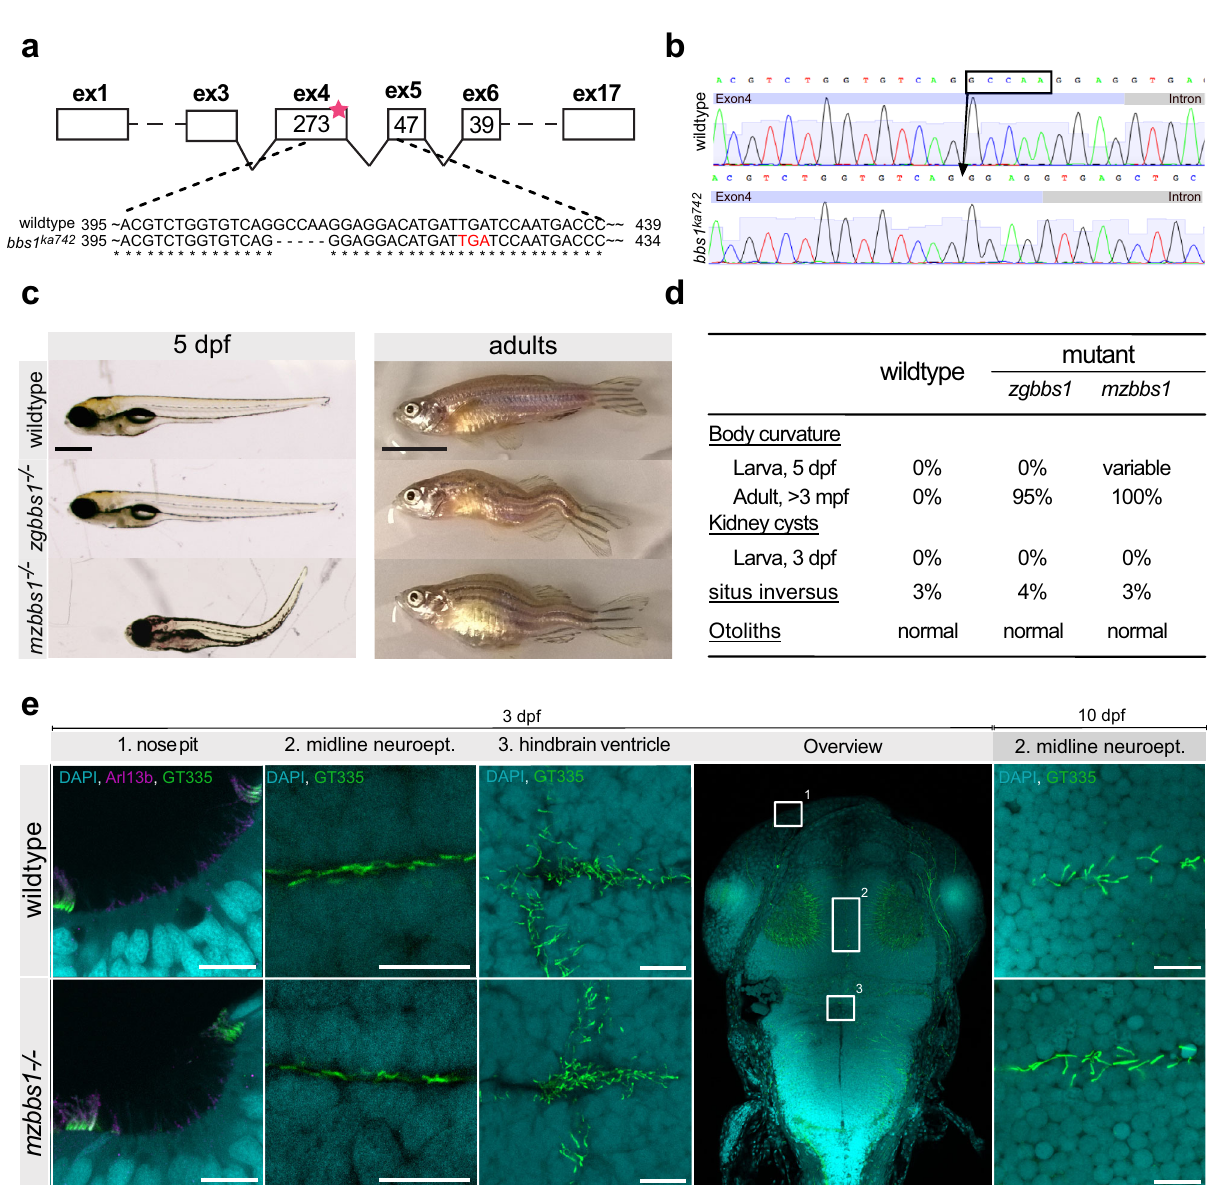
Fig. 1 Characterization of bbs1 mutant zebra fi sh. a Deletion of 5 bp in exon 4 of bbs1 causes a frameshift resulting in a premature termination (red letters) (cDNA). b Sanger sequencing of the gDNA fl anking the indel highlighting the exon (bright blue box) and the intron (grey box). c Lateral view of 5 dpf larvae and adults (>3 months post fertilization (mpf) with wildtype in the top panel, zygotic mutant ( zgbbs1 ) in the middle panel and maternal zygotic mutant ( mzbbs1 ) in the bottom panel. Of note, presence and degree of body curvature varied in mz mutants (>100 clutches collected). d Summary of the phenotypic characterization with respect to typical cilia-associated phenotypes showing differences between zygotic and maternal zygotic mutants for larval body curvature. Note that scoliosis is present in nearly all zygotic and in all maternal-zygotic adult mutants. Sample sizes: 5dpf n = 200/genotype, adult: n = 60/genotype, 3 dpf kidney/situs inversus/otoliths: n = 100/category. e Whole mount immunostaining of various ciliated tissues including nose pit, midline neuroepithelium, hindbrain ventricle cilia at 3 days post fertilization (dpf) and midline neuroepithelium at 10 dpf. Nose pit cilia were labelled using anti-Arl13b (magenta) or anti-glutamylated tubulin GT335 (green) antibodies. Midline and hindbrain cilia were stained only using anti-glutamylated tubulin GT335 (green). Note that no differences in abundance or morphology of cilia were observed between mz bbs1 mutants (bottom) and their sibling controls (top). All close-up images are dorsal views with rostral to the left and caudal to the right. The overview image indicates orientation. Scale bars: ( c ) 0.5 mm (larvae), 1 cm (adult), ( e ) 10 µ zebra fi sh BBS1/Bbs1 is 69% (Supplementary Fig. 2). We targeted stop-codon leads to partial nonsense-mediated mRNA decay Exon 4 of bbs1 using the CRISPR/CAS9 gene editing system, to based on decreased bbs1 mRNA levels in the bbs1 k742 allele as seen by RNA sequencing (see below). Given the presence of some introduce a 5 bp deletion resulting in a frameshift and premature residual bbs1 mRNA in the mutants, we further con fi rmed the stop codon at nucleotide position 421 (Fig. 1a, b). The theoretical absence of mutation-induced alternative splicing in 10dpf truncated protein would contain the fi rst 24% of the protein mutants and adults using RT-PCR and RNAsequencing (Sup- but lack important domains such as the b-propeller and plementary Fig. 3A – C). We next sought to determine Bbs1 GAE (Gamma-adaptin ear) 16 domains. However, the predicted